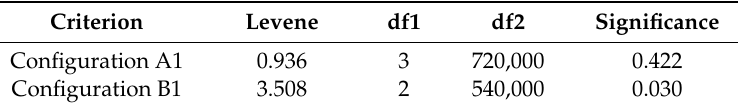
Table 14. Variance homogeneity test result of vehicle speed.